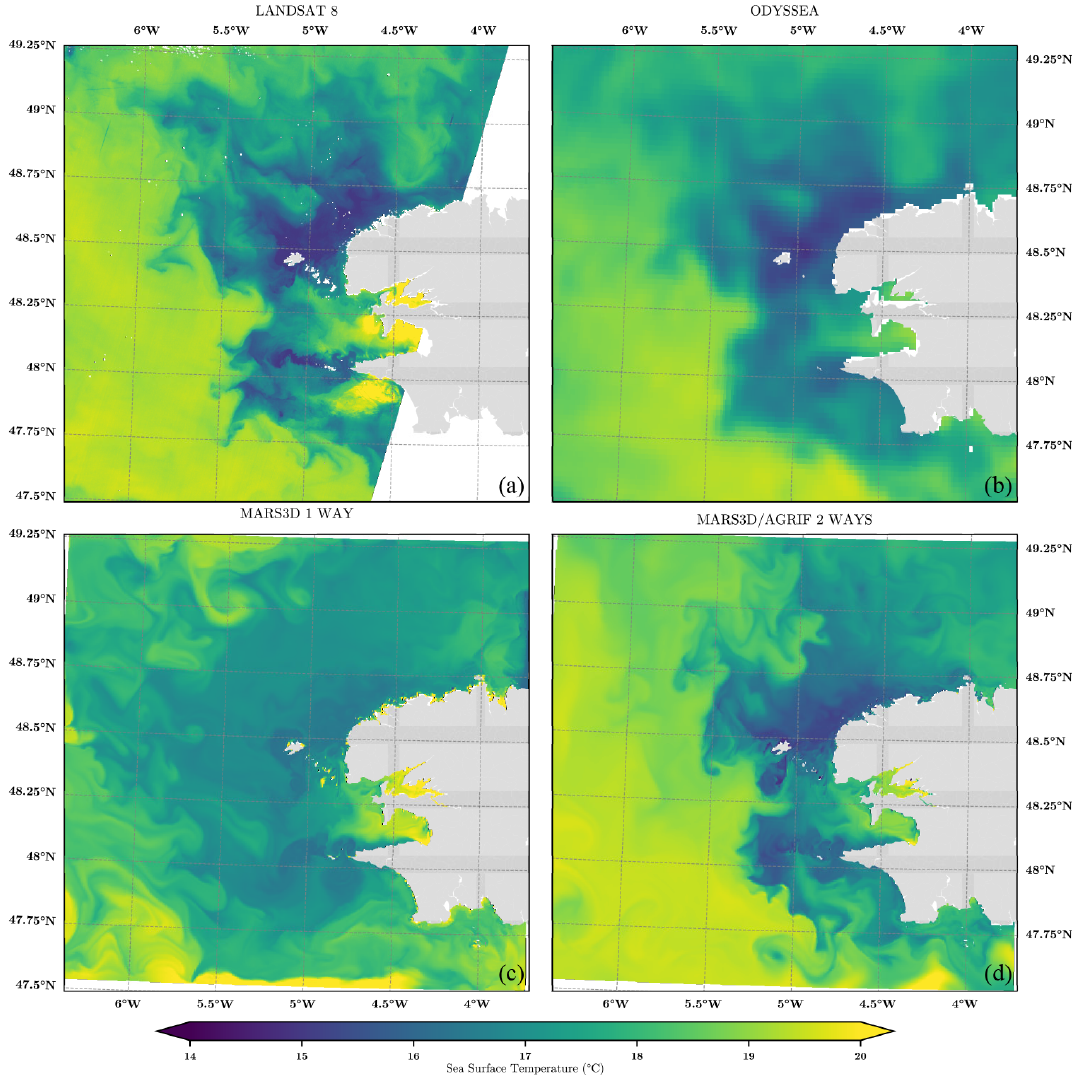
Figure 7. Sea surface temperature over the Iroise Sea on 15 August 2016 for Landsat 8 (a) , ODYSSEA (b) , a one-way simulation (c) and a two-way simulation (d) . Coastline source: